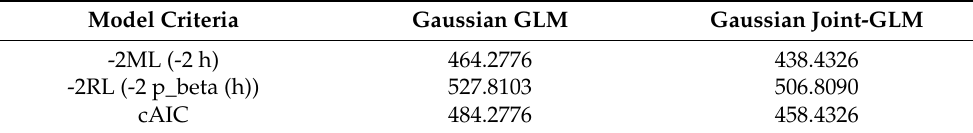
Table 5. Model criteria for Gaussian GLM and Gaussian